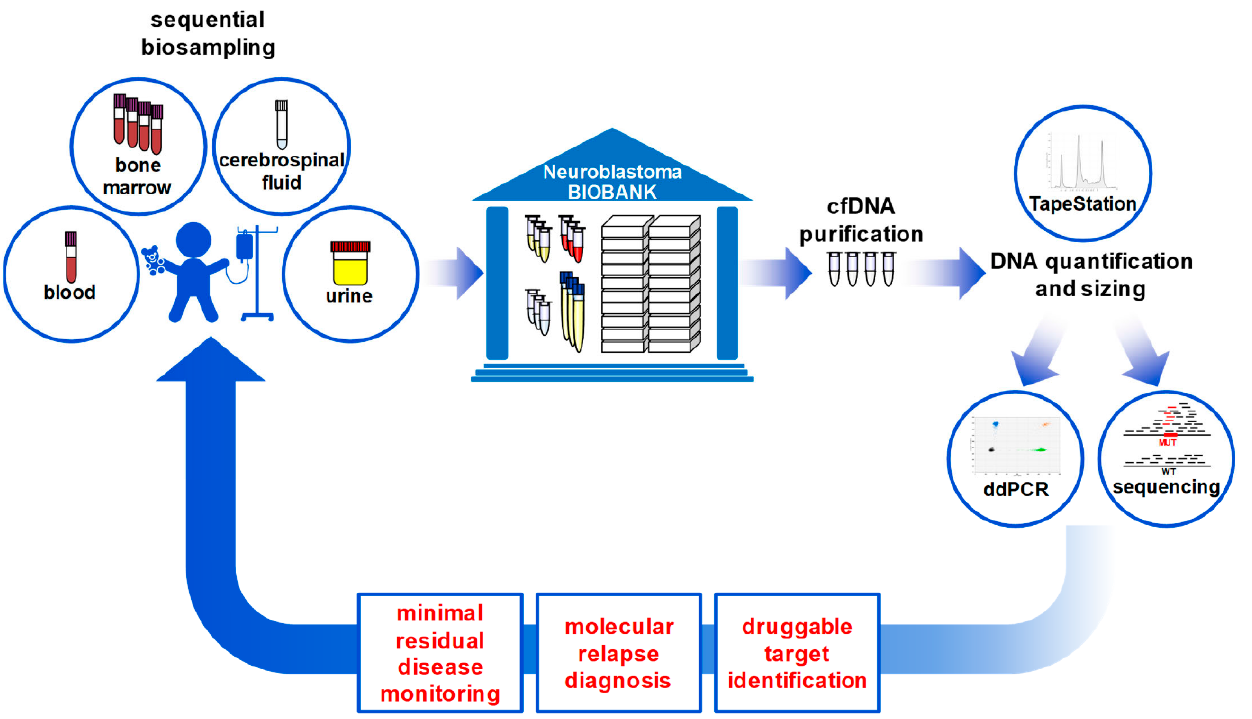
Figure 7. Graphical abstract demonstrating the workflow of liquid biopsy-based cfDNA diagnostics in patients with neuroblastoma.